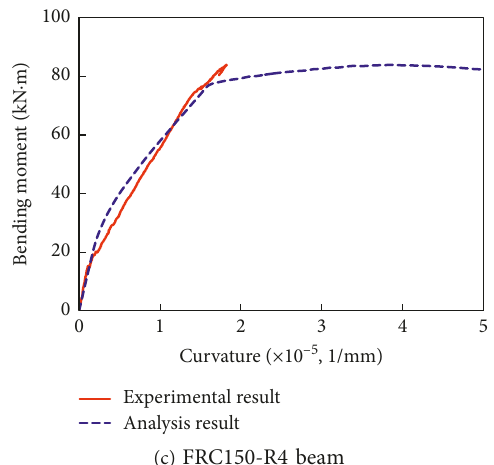
Figure 16: Fitting of moment-curvature curves between the experimental and analysis results (FRC150 series beams).